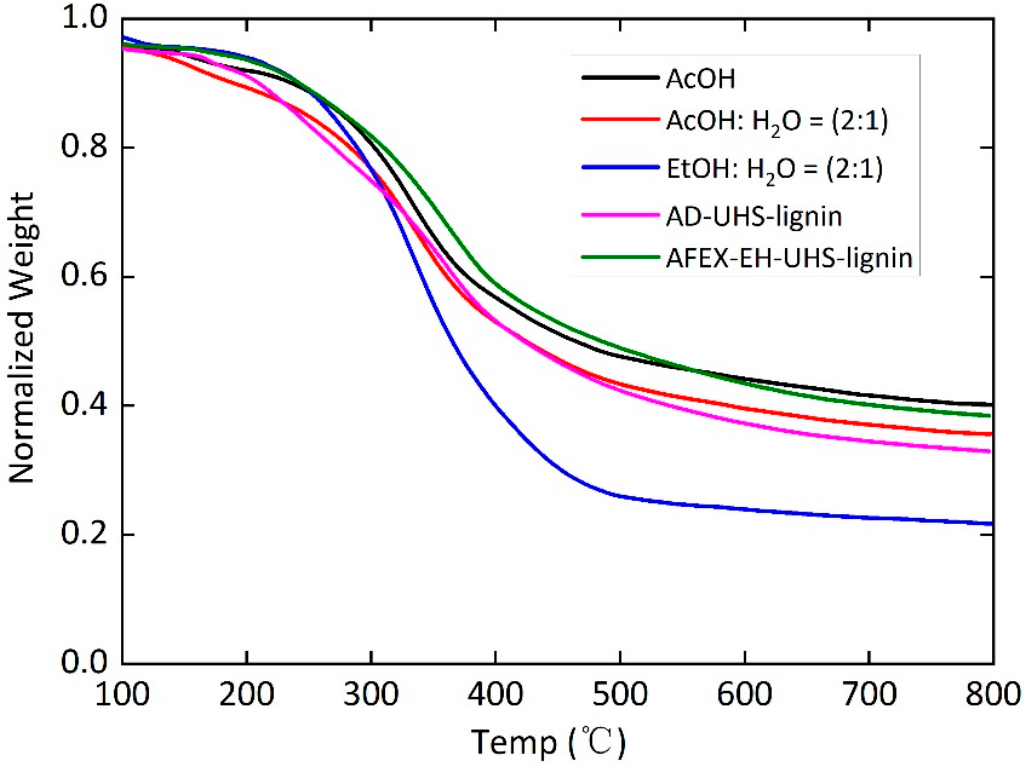
Figure 2. Thermogravimetric curves for material extracted from AD-UHS with three solvents, and standard lignin of AFEX-EH-UHS and AD-UHS.